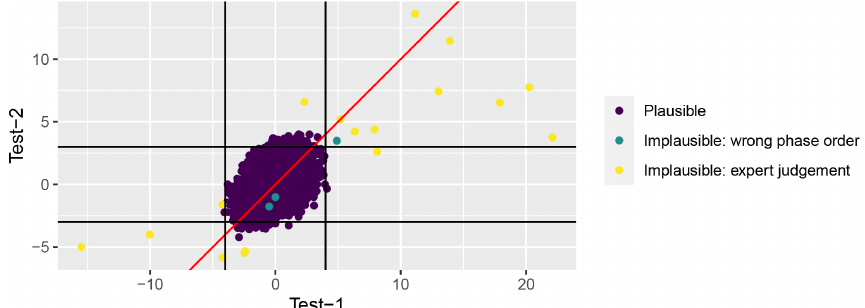
Figure 3. Association between Test 1 (standard deviation from yearly median of the given phase) and Test 2 (standard deviation from station median of the given phase); black lines indicate thresholds of 4 (Test 1) or 3 (Test 2) standard deviations.